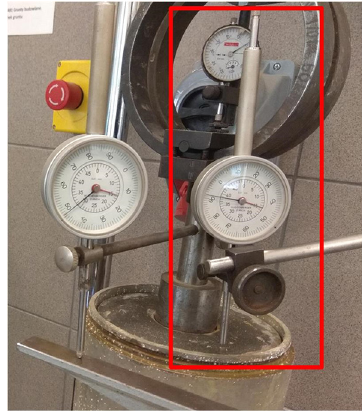
Figure 4. The location of the annular surcharge ring displacement sensor in the CBR